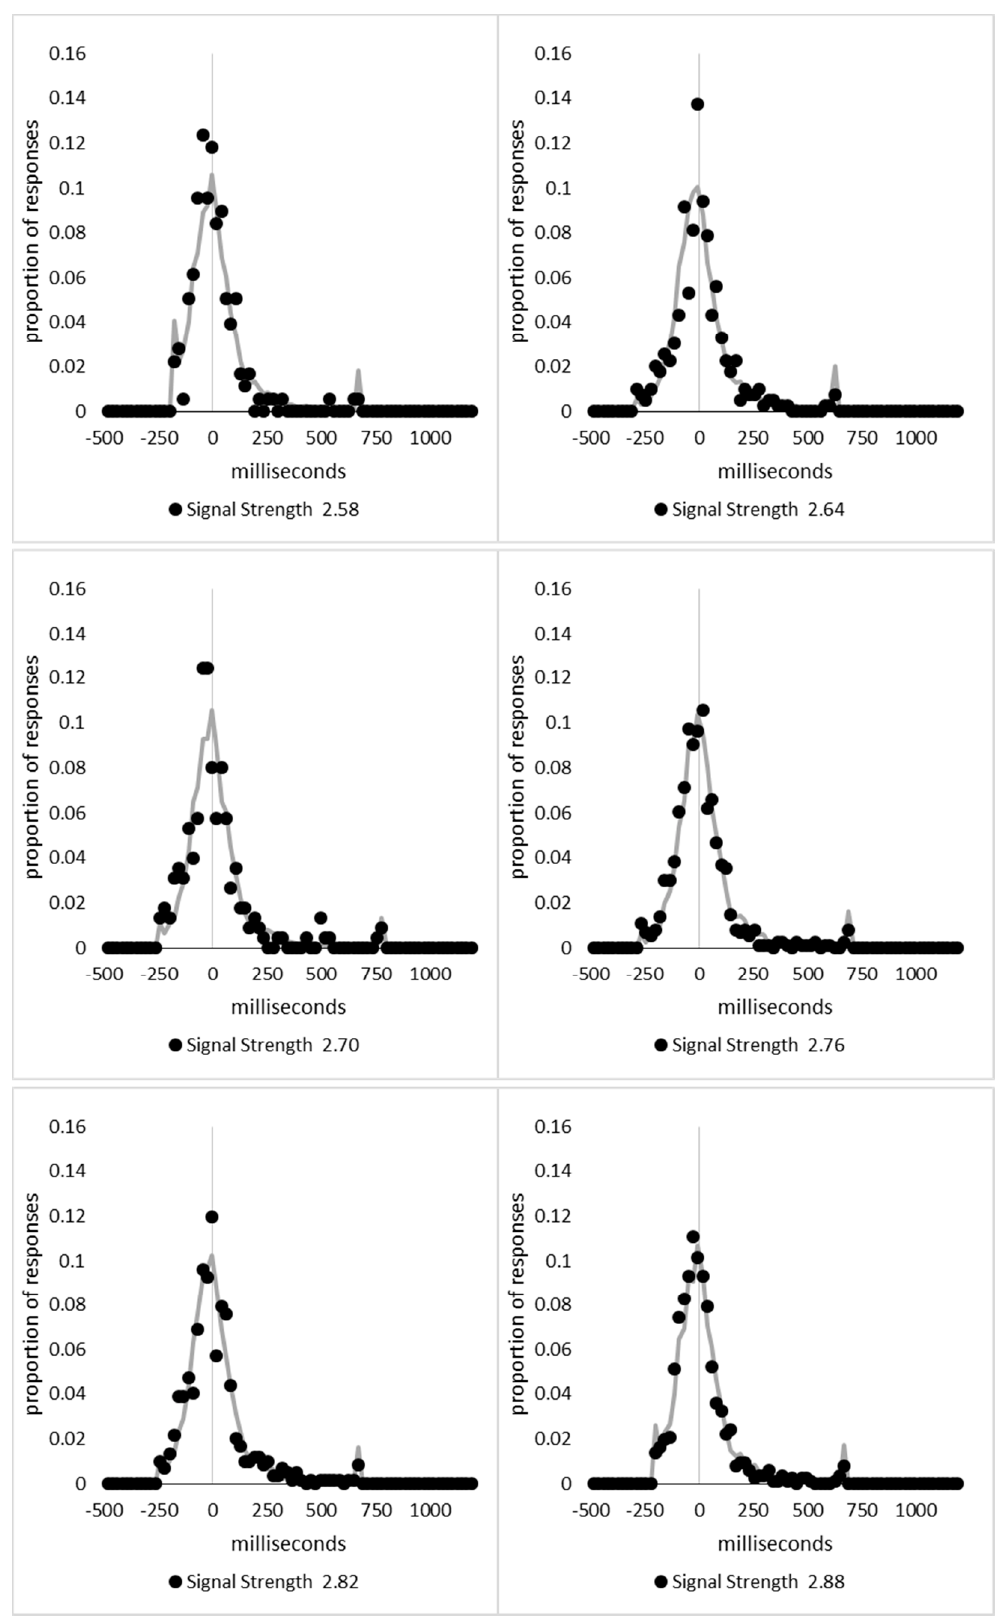
Figure A8. Density functions of the observed data (filled circles) and model (solid line) for signal strength bins 2.58 to 2.88.